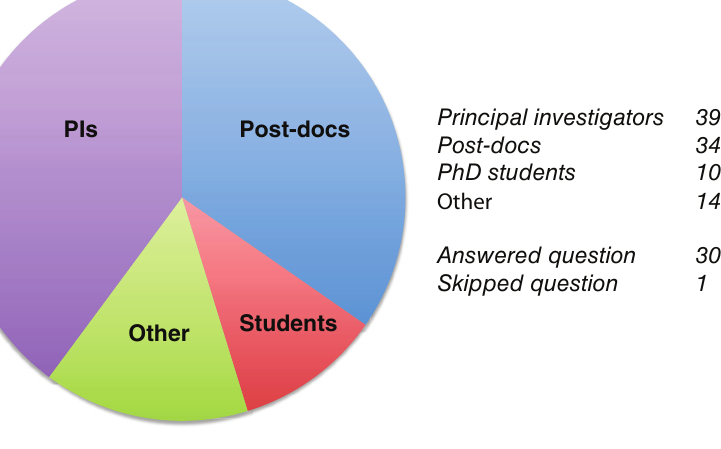
Figure S1. Academic positions of the surveyed scientists.